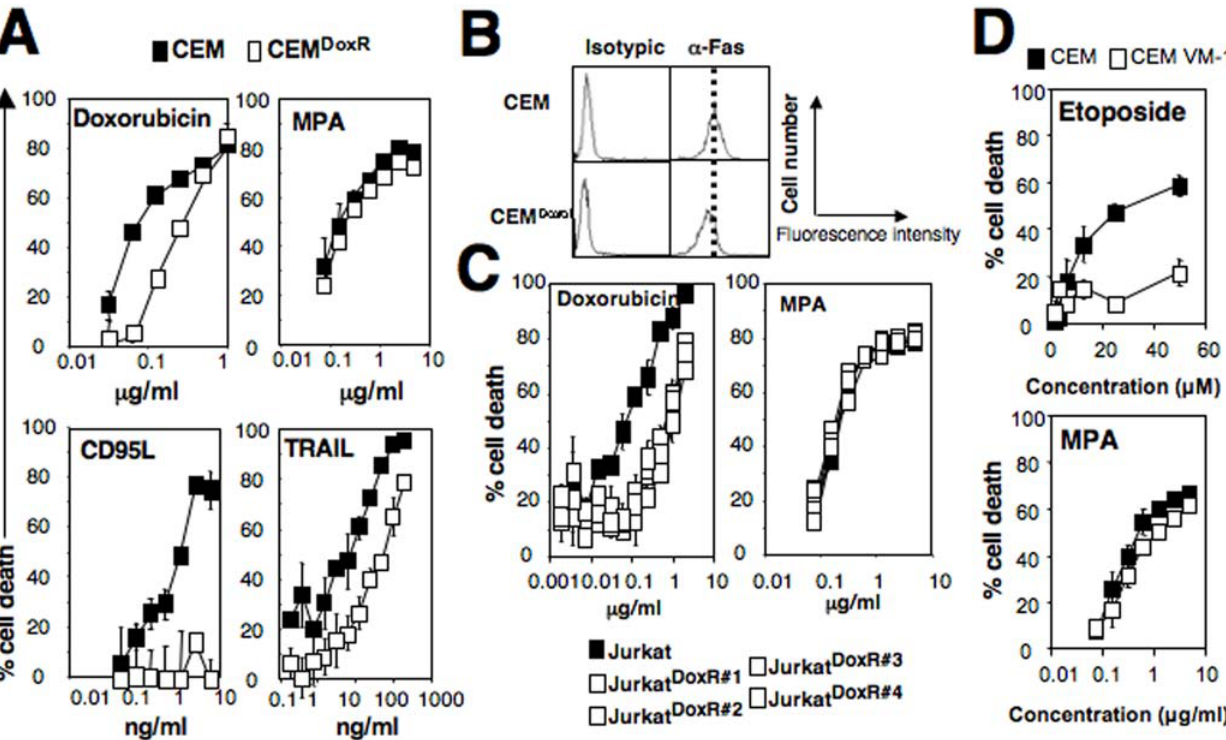
Figure 3. Apoptosis resistances are bypassed by the MPA–mediated necrotic signal. (A) Parental CEM and doxorubicin-resistant CEM (CEM DoxR ) were incubated with indicated dose of doxorubicin, CD95L, TRAIL or MPA for 48 hours. Cell death was measured using a MTT assay. (B) Flow cytometry analysis of the CD95 expression on the doxorubicin-resistant CEM. (C) Parental Jurkat and the selected doxorubicin resistant clones (Jurkat DoxR ) were incubated for 48 hours with doxorubicin and MPA at the indicated concentrations. MTT assay was performed to quantify cell death. (D) CEM and the etoposide resistant CEM-VM1 were incubated with the etoposide or MPA for 48 hours and cell death was assessed using MTT assay. Results shown represent the mean 6 SD of three independent